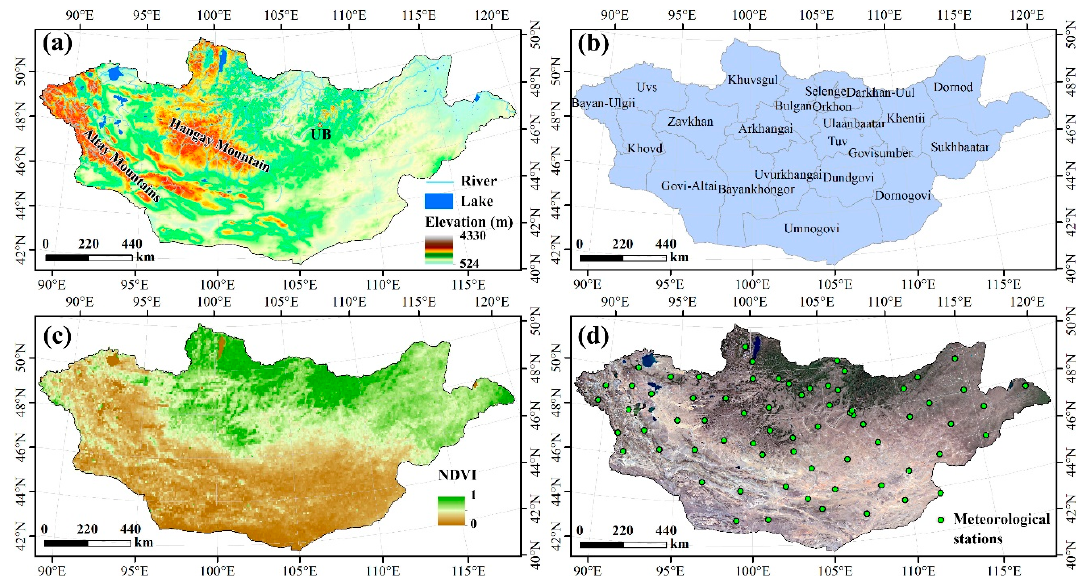
Figure 1. Geographic characteristics of Mongolia: ( a ) general geographical map (UB refers to Ulaanbaatar), ( b ) provincial administrative map, ( c ) map of annual average of normalized density vegetation index (NDVI), and ( d ) distribution of meteorological stations in Mongolia.